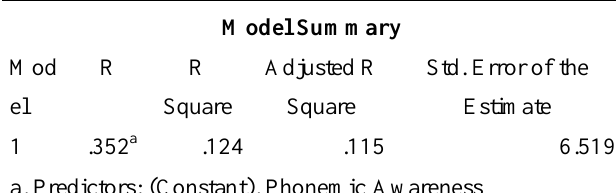
TABLE 5 | Model Summary of Simple Linear Regression Test between English Phonemic Awareness (X) and Reading Comprehension (Y)